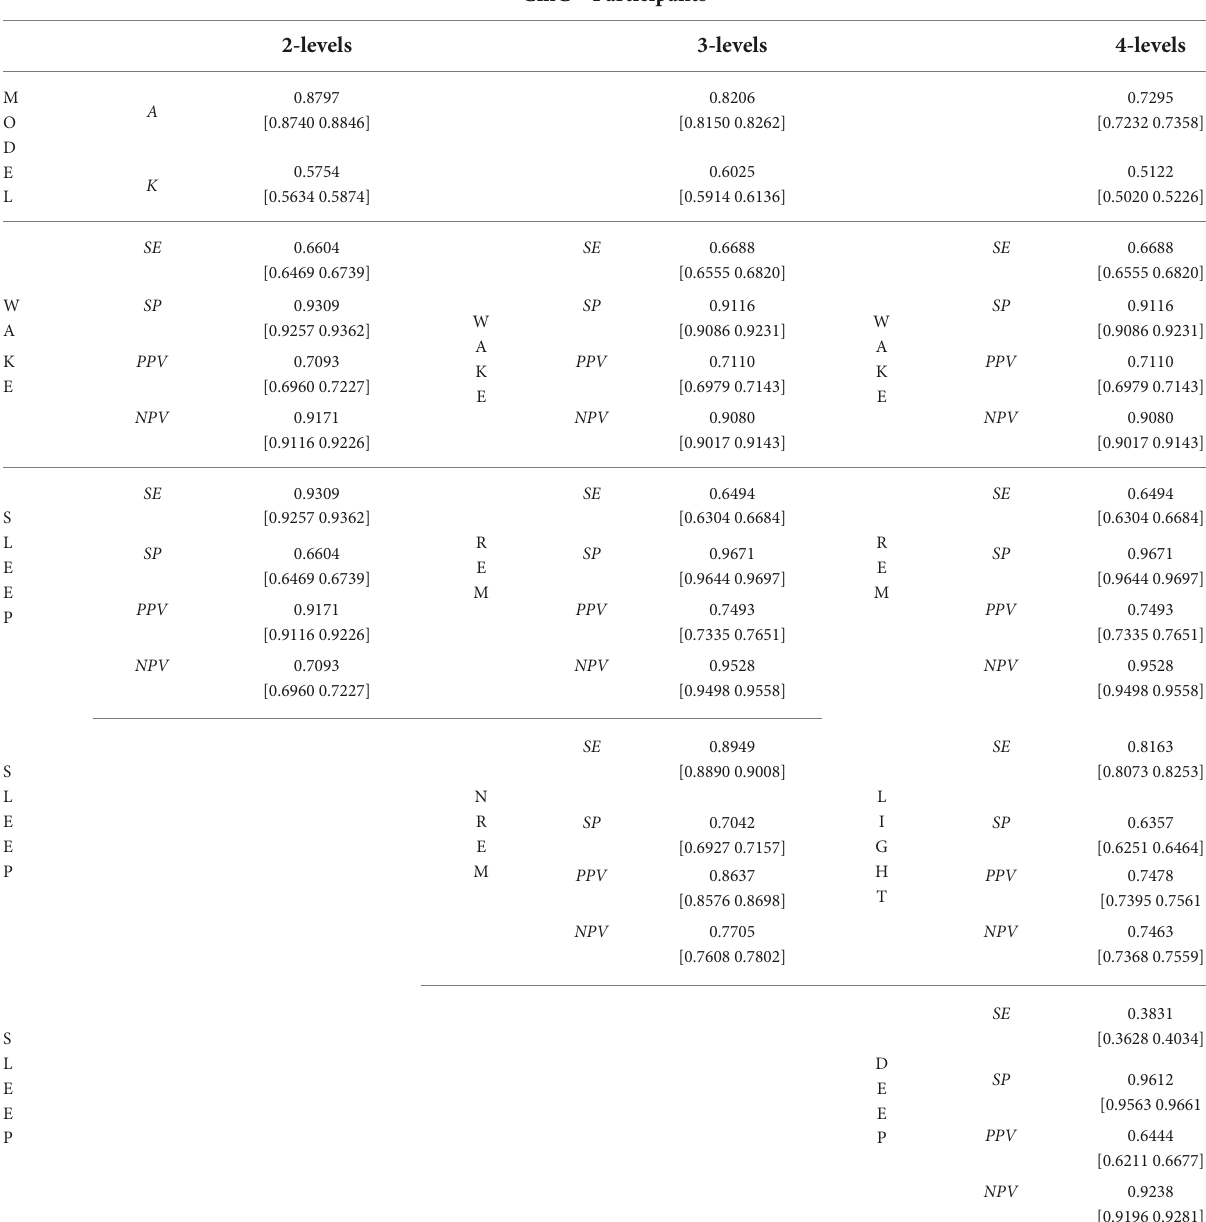
TABLE 2 Mean and [95% Confidence Intervals] Accuracy (A), Cohen’s kappa (K), Sensitivity (SE), Specificity (SP), Positive Predictive Value (PPV), and Negative Predicted Value (NPV) were obtained by firstly collapsing metrics within and subsequently across participants in the CinC